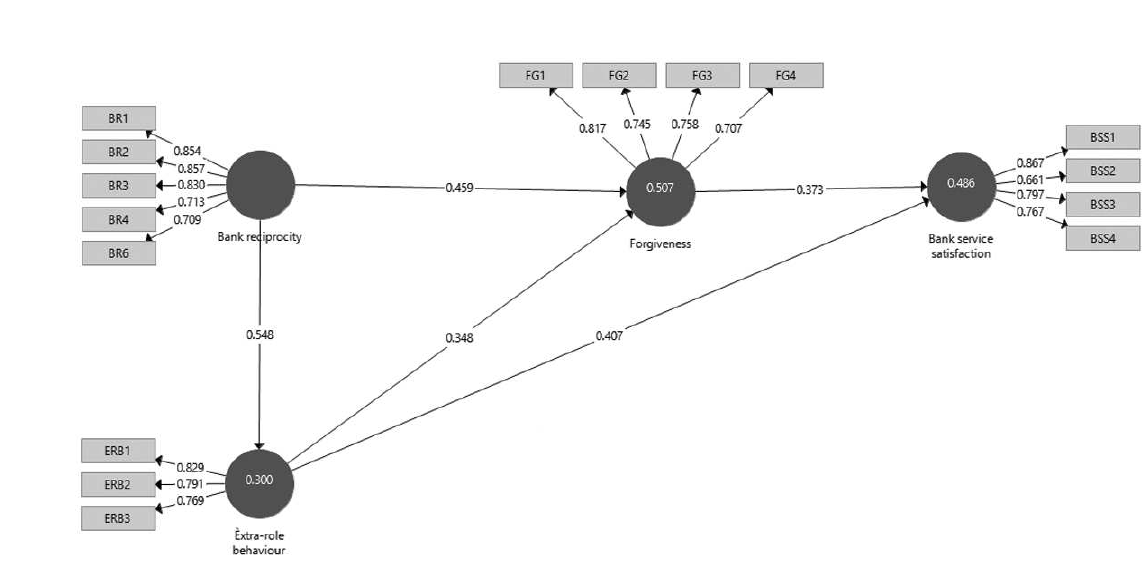
Figure 1. Inner model